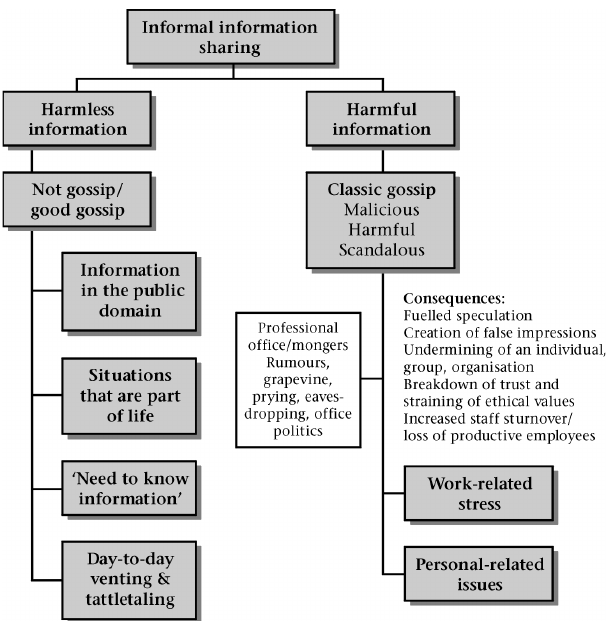
Figure 3: Typology of Gossip in the Workplace